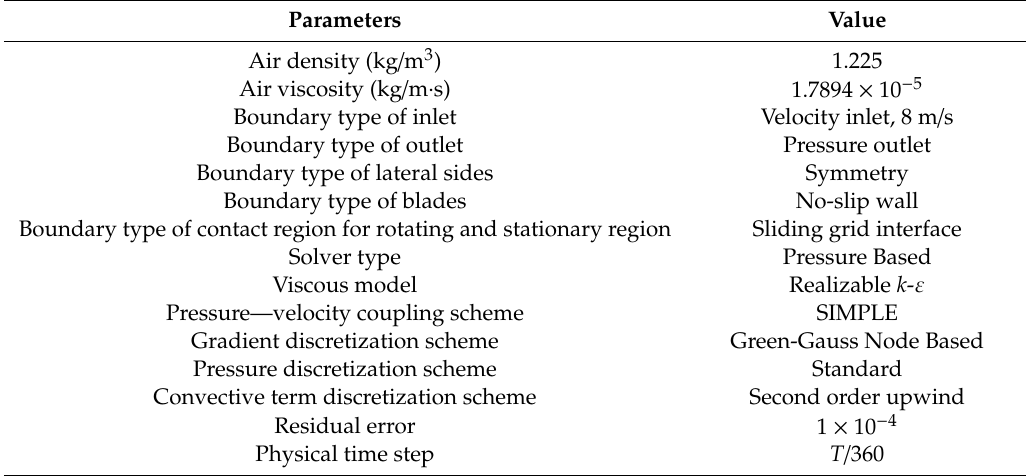
Table 3. Numerical settings of VAWT.